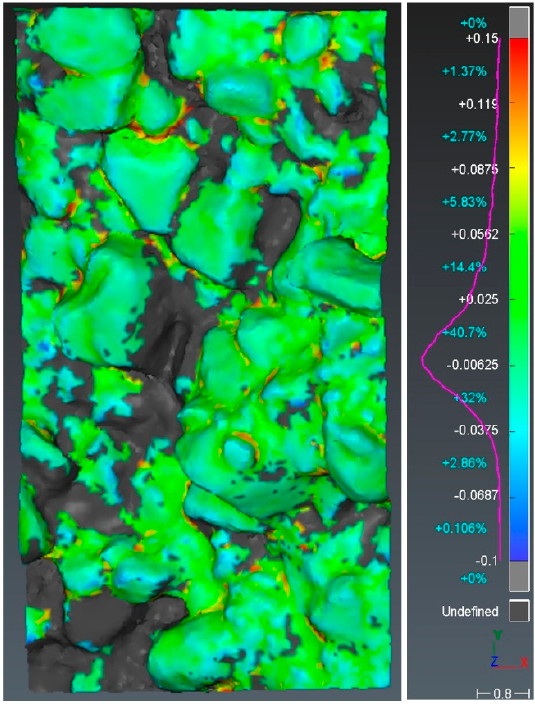
Figure 15. Height comparison of TLS and UAS clouds on the vegetation-free area and the histogram in the range up to 150 mm.